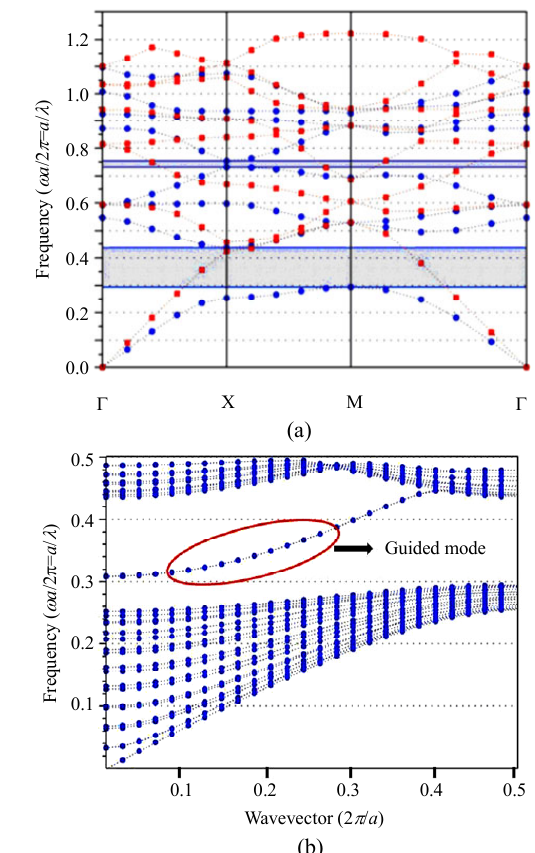
Fig. 1 Band diagram for circular rods in 21×21 square lattice: (a) without any defects and (b) with line and point